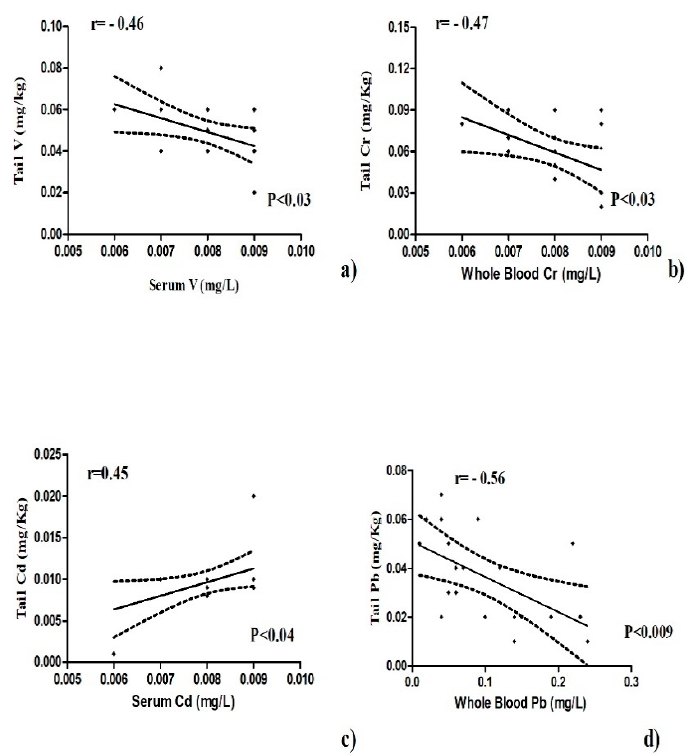
Figure 3. Negative correlation of V, Cr, and Pb in tail with serum ( a ) and whole blood samples ( b , d ). Positive correlation of Cd in tail with serum ( c ) shown as Pearson’s correlation coefficients and significant values.